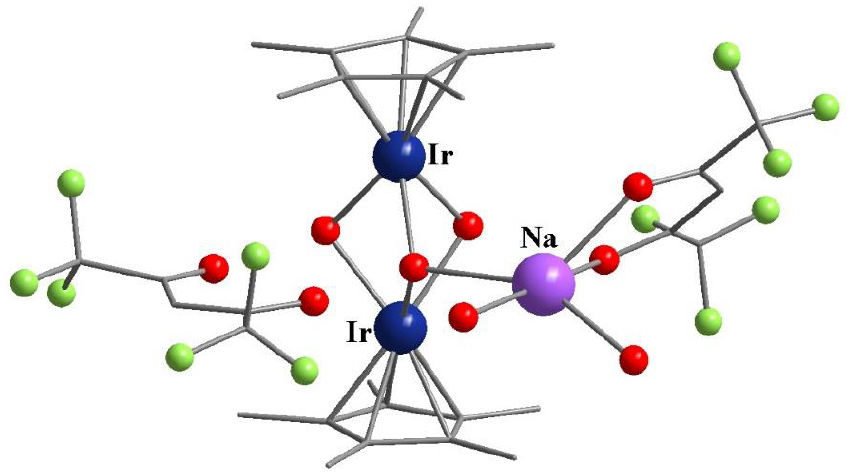
Figure 31. Molecular structure of 62 [102]. Hydrogen atoms have been omitted for clarity. The cif has been retrieved from CCDC. CCDC number is 1996249.